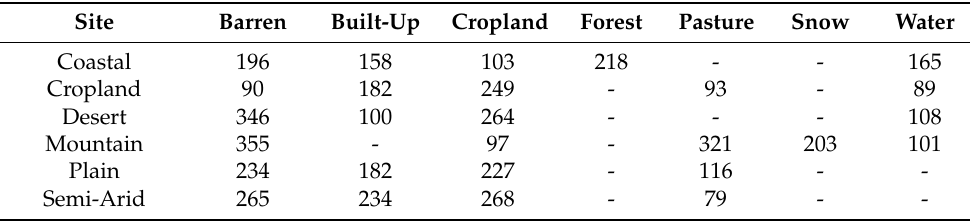
Table 2. Information of GCPs.